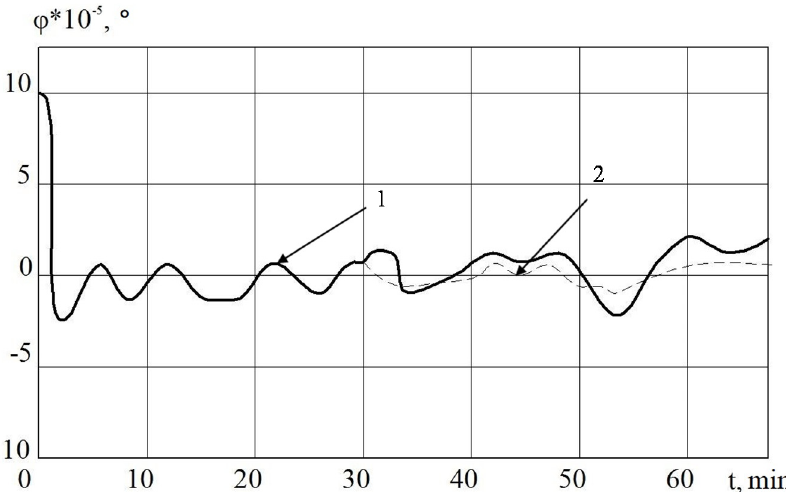
Figure 5. The deviation angle of the gyro-stabilized platform (GSP) in INS from the horizon plane when using MC with a regulator (1) and a non-linear regulator (2).